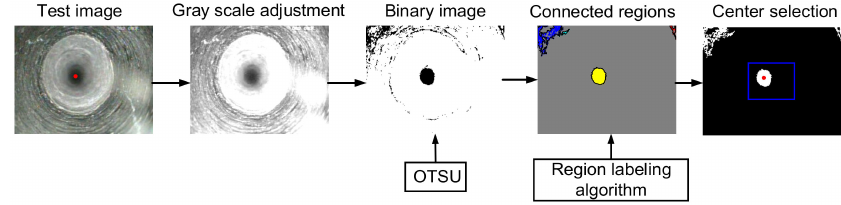
Figure 3. Steps involved in locating the drilled hole